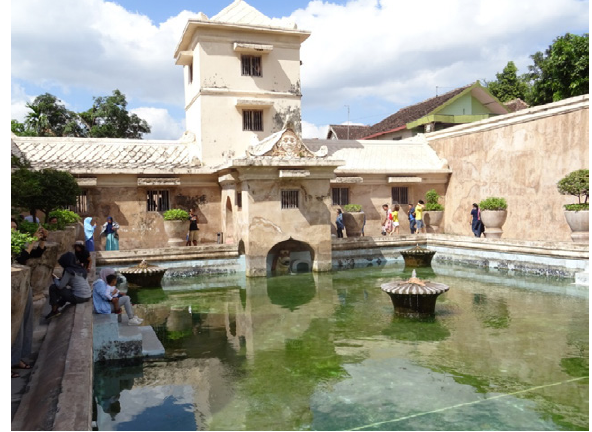
Figure 6. Swimming pool in Tamansari, Jogyakarta, Indonesia in the site of former royal garden of the Sultanate of Yohyakarta – part of the Umbul Pasiraman bathing complex previously intended for sultan’s concubines (photo by the author of the article)